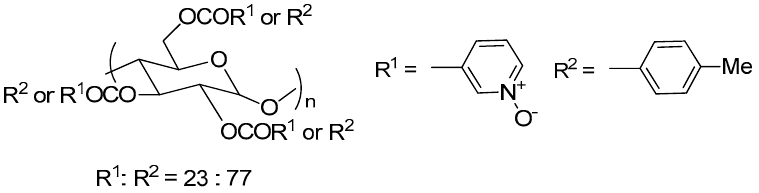
Figure 3. N-oxide derivative of amylose.